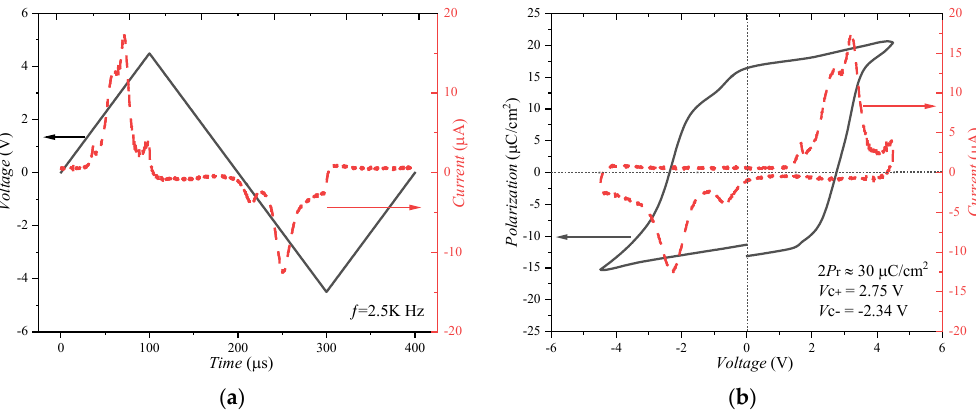
triangular pulse sequence are V P = 4.5 V and V N = − 4.5 V, respectively. The transient current response of a ferroelectric capacitor under triangular excitation gate voltage is shown by the red dotted line in Figure 10a. There are two characteristic current peaks in the current versus the time curve, corresponding to the domain switching under the coercive voltage ( V C ).